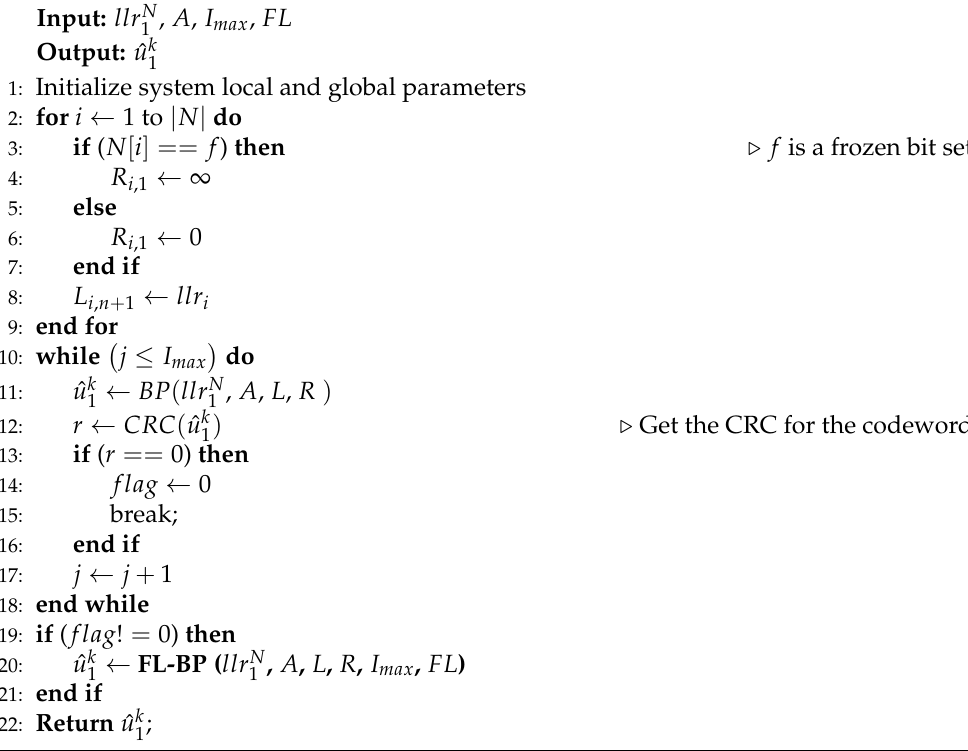
Algorithm 1 Main algorithm of the proposed FL-BP decoding.